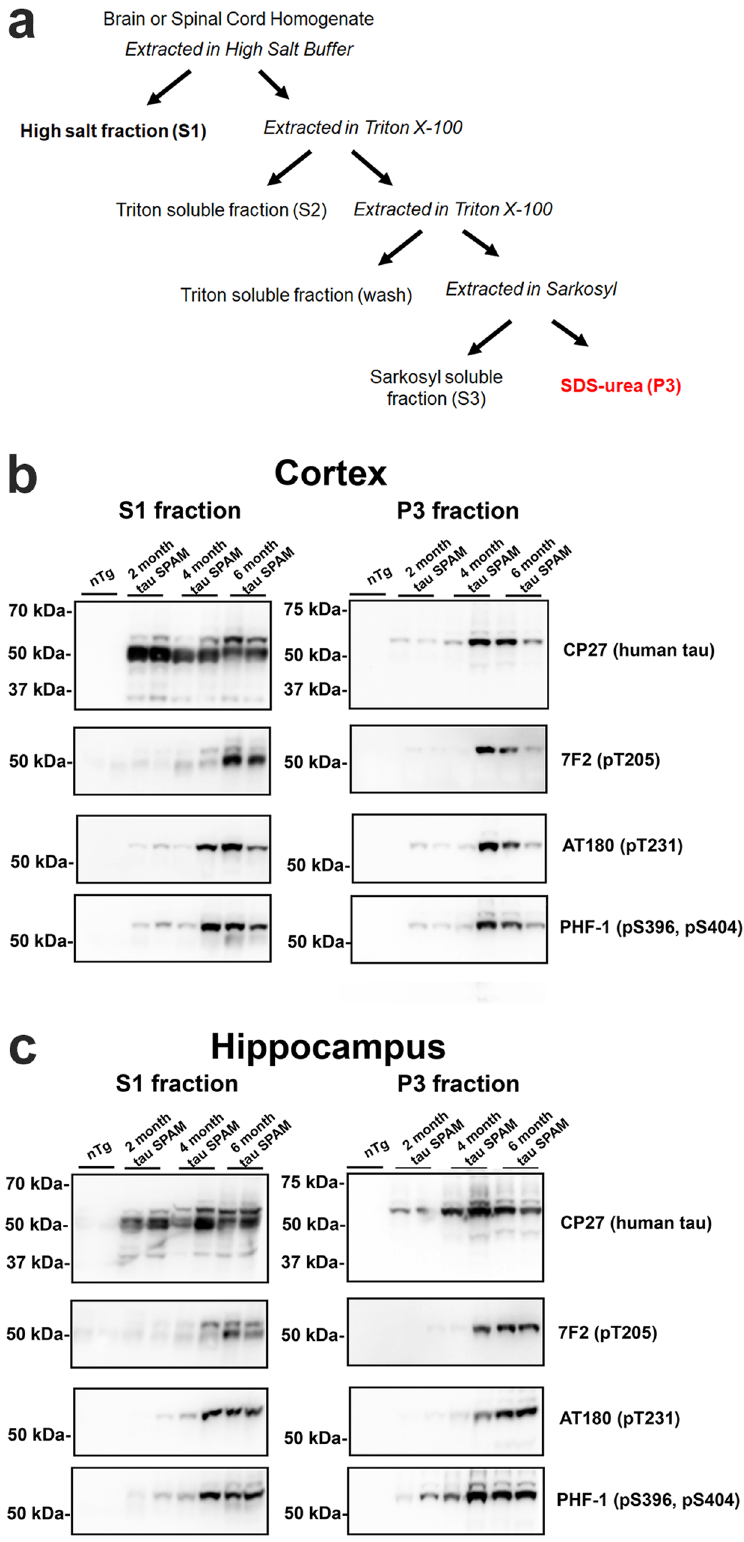
Fig. 3 Temporal accumulation of aggregated, hyperphosphorylated tau in tau SPAM mice. a Summary diagram of biochemical, sequential extraction used. The S1 fraction contains primarily soluble tau and the P3 fraction contains Triton X-100 and Sarkosyl-insoluble tau. b Brain cortex and ( c ) hippocampus from tau SPAM mice at 2, 4, and 6 months of age were sequentially extracted. The soluble fraction (S1) and pellet fraction (P3) were resolved by immunoblotting with CP27 antibody speci fi c for human tau and tau phospho-speci fi c antibody 7F2, (pThr205), AT180 (pThr231), or PHF1 (pSer396/pSer404). The relative molecular mass markers are shown on the